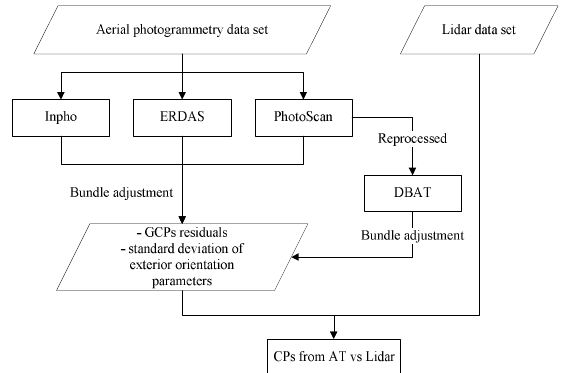
Figure 3. Flowchart of the experiments conducted in this paper.